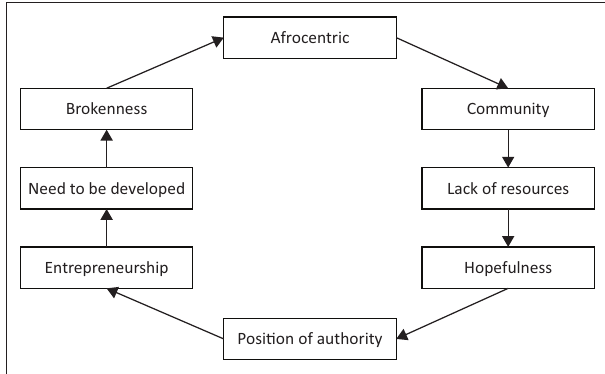
FIGURE 1: Inter-relational plot on African business leadership. The eight themes are connected using an arrow to show their interrelation and how the one flows into the other, with ‘Afrocentric’ being the theme marking the point of departure.